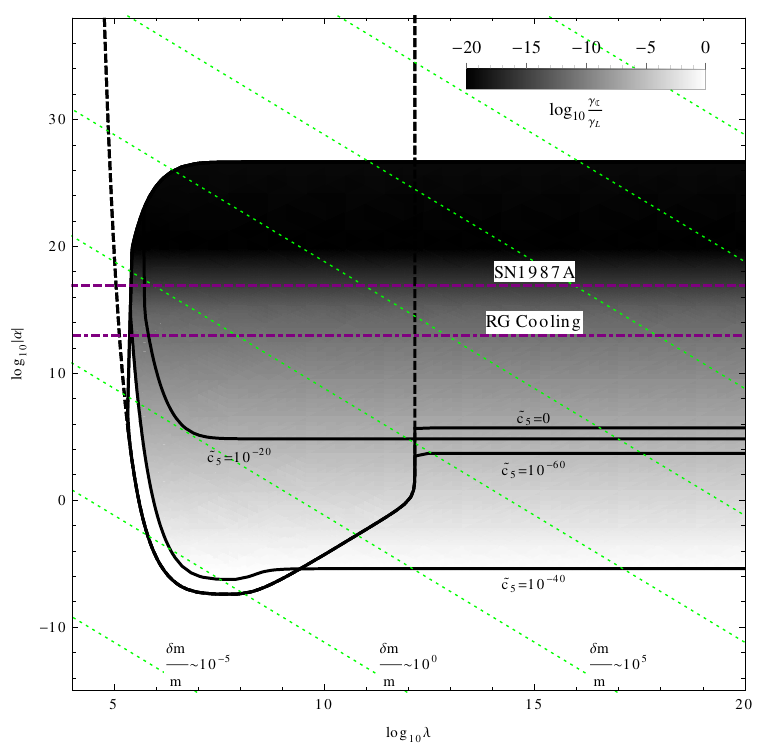
Figure 8 . Variation of the Lunar-LAGEOS constraint for d (cid:16) 5 self-interactions with a tree-level contribution ~ c 5 { M Pl to the Wilson coe(cid:14)cient as we change ~ c 5 between 10 (cid:1) 60 and 10 (cid:1) 20 . At (cid:12)rst, the excluded region grows are large (cid:21) but then starts to decrease when ~ c 5 is large enough. The non-monotonic scaling of the bound is explained in the